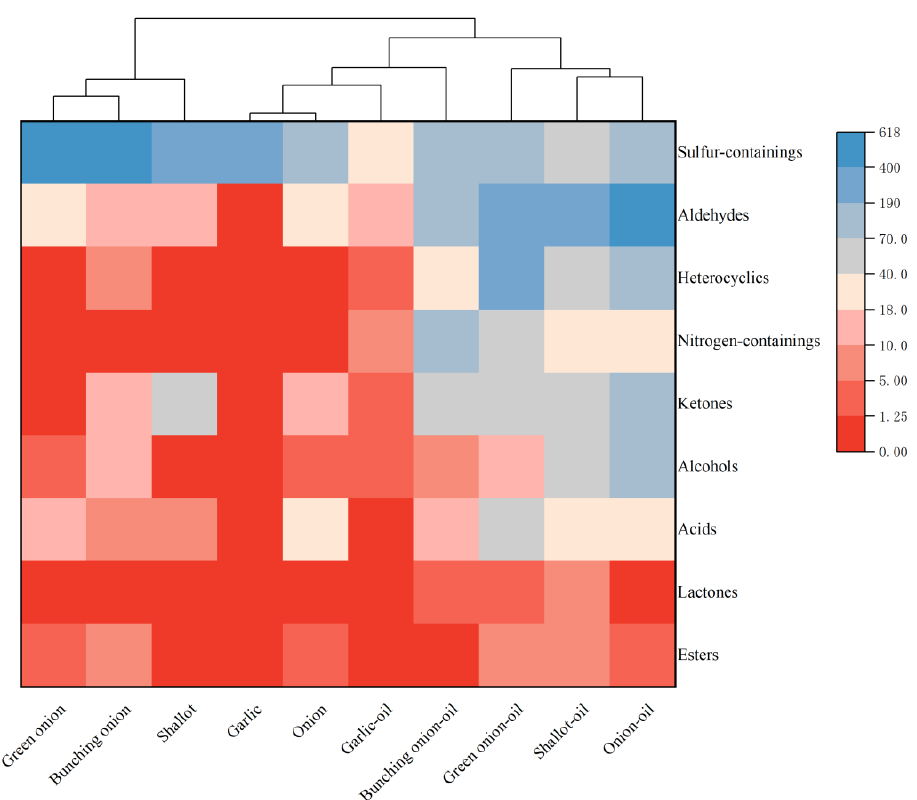
Figure 4. A heat map showed the volatile compound concentration present in five fresh Allium plants and their fried